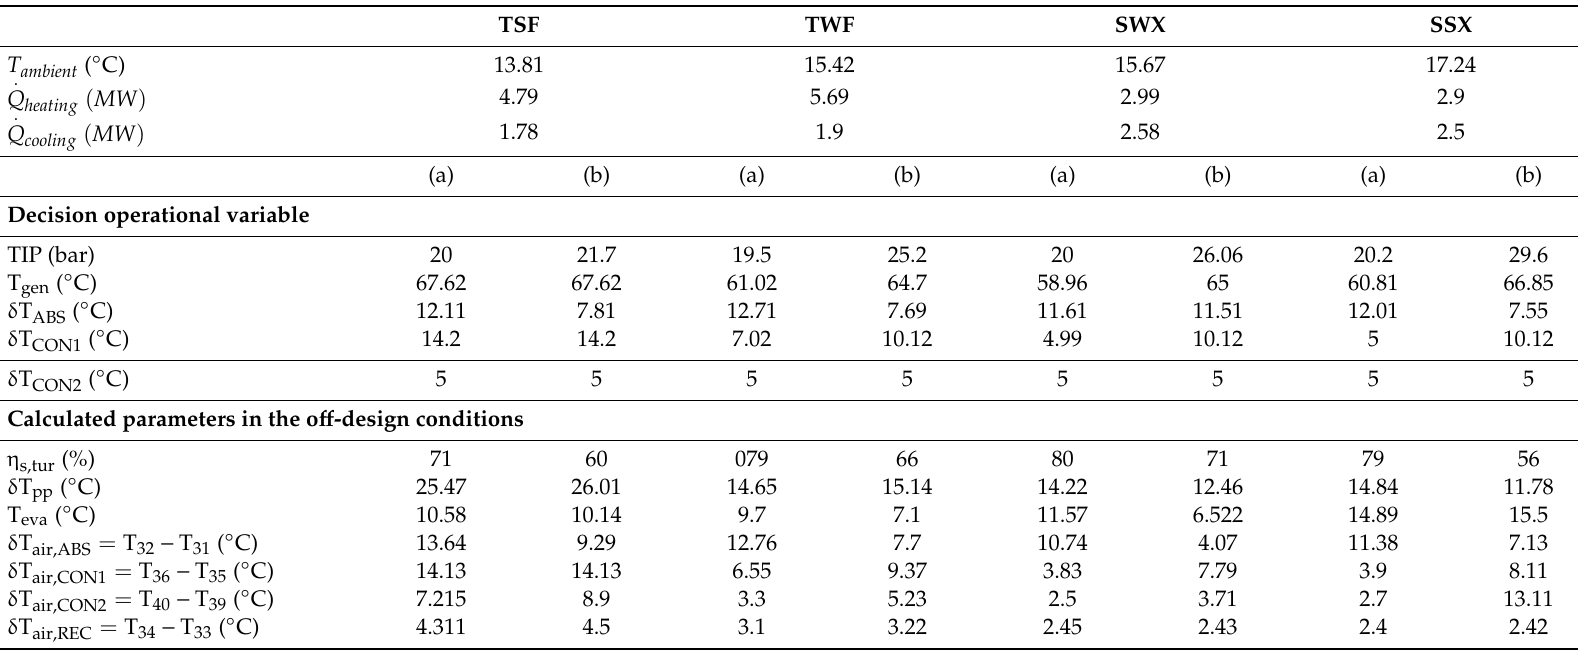
Table A2. Detailed parameters of the optimization calculation (a) maximum exergy e ffi ciency (b) minimum exergy destruction rate.